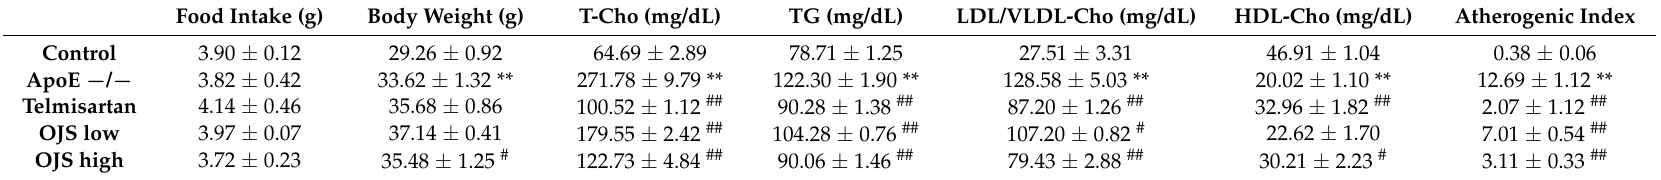
Table 3. Effect of OJS treatment on plasma biomarker levels in Apolipoprotein-E gene knockout (ApoE − / − )